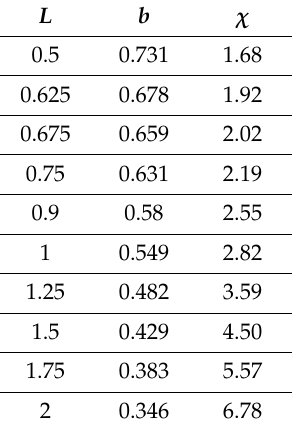
Figure 1. Channels with spherical ( a ), 10 ◦ -truncated conical ( b ) and oval dimples of width b = 0.731 ( c ), 0.549 ( d ), 0.429 ( e ) and 0.346 ( f ). Table 1. The cylindrical insert length, the width of the oval dimple and its length in terms of width.